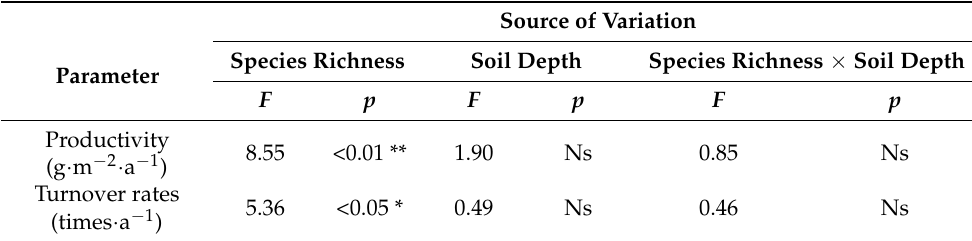
Figure 2. Morphological characteristics of fine roots in plant communities with different tree species richness. ( a ) Root tissue density; ( b ) Root length density; ( c ) Specific root length; ( d ) Specific surface area; ( e ) Root surface-area density.SR1, Ligustrum lucidum monoculture forest; SR2, Melia azedarach mixture forest; SR3, Sapium sebiferum mixture forest; SR4, Populus deltoids mixture forest; SR5, Broussonetia papyrifera mixture forest; SR6, Salix matsudana mixture forest; SR7, Cinnamomum camphora mixture forest. The same below. Table 3. Results of ANOVA of the effects of tree species richness and soil layers on the annual productivity and turnover rate of fine